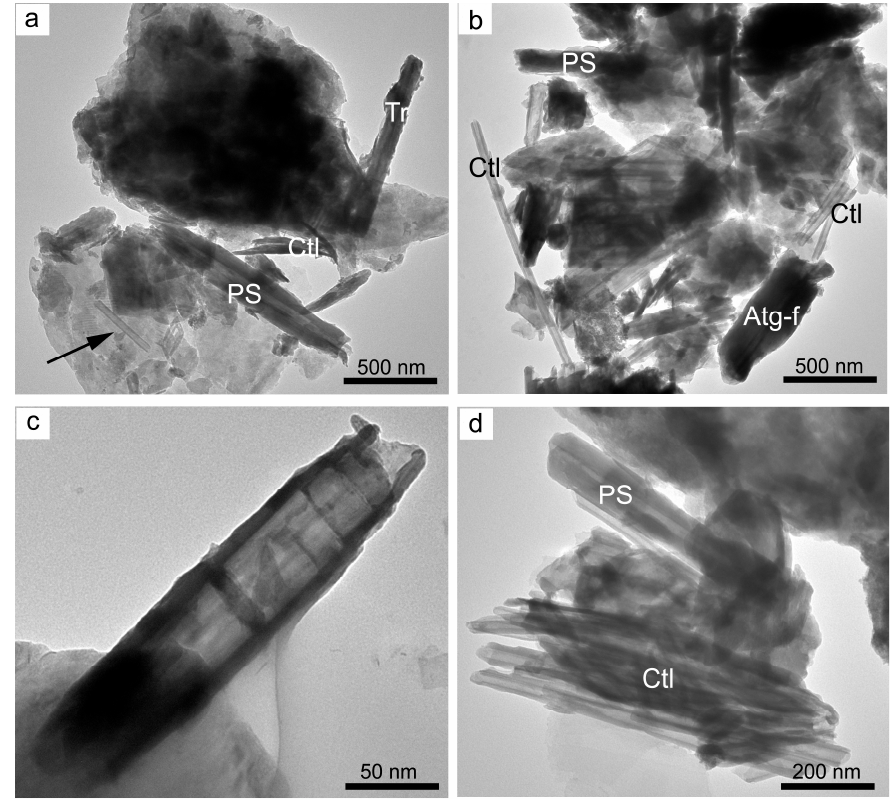
Figure 3. Representative TEM images of fibrous mineral detected in the soil samples: ( a ) bundles of chrysotile fibers; chrysotile fiber characterized by the empty central cavity and thin outer walls indicated by black arrow; polygonal serpentine and fibrous tremolite (sample Spol1); ( b ) chrysotile fibers, polygonal serpentine and fibrous antigorite (Spol3); ( c ) chrysotile fiber partially unrolled from the inside like cylinder-in-cylinder morphology (Spol10); ( d ) polygonal serpentine and bundles of chrysotile fibers (Spol11). Ctl = chrysotile; Tr = tremolite; Atg-f = fibrous antigorite; PS = polygonal serpentine (mineral symbols after Whitney and Evans [39]).